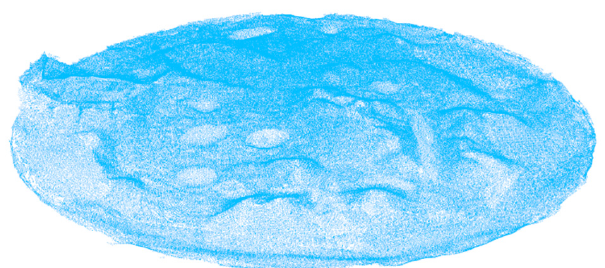
Figure 11. Unstructured terrain point cloud after filtering (413591 points).